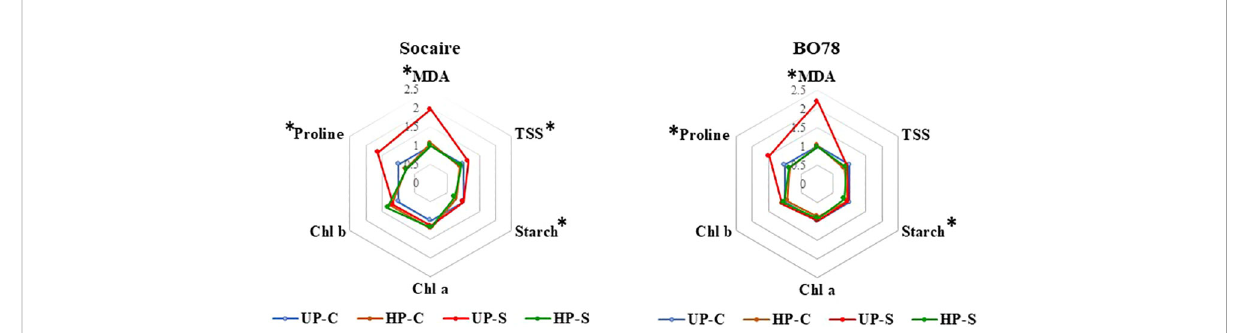
FIGURE 5 Salinity and priming effect on metabolites in Socaire and BO78 ecotypes of quinoa. Radar chart shows relative changes in lipid peroxidation (measured as MDA levels), total soluble sugars (TSS), starch, chlorophylls (Chl a and b ), and proline. Relative changes were calculated as the ratio of the content of each metabolite to UP-C samples, for each ecotype. Asterisks indicate signi fi cant differences among